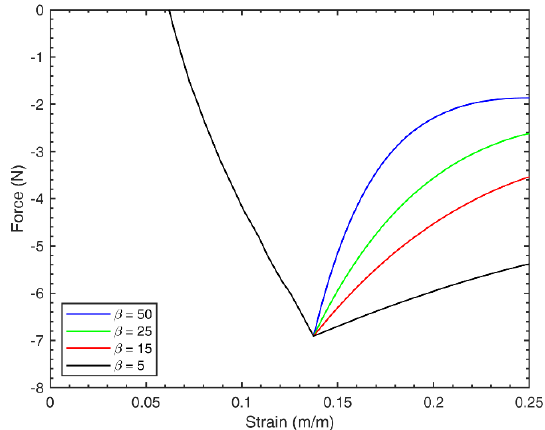
Figure 7. Effect of transition constant 𝛽 used to characterize the transition from post-buckling to post-collapse region. The resistive forces are shown for a fluidic artificial muscle (FAM) with identical dimensions as that of Figure 6 and for an applied pressure of 34.5 kPa.